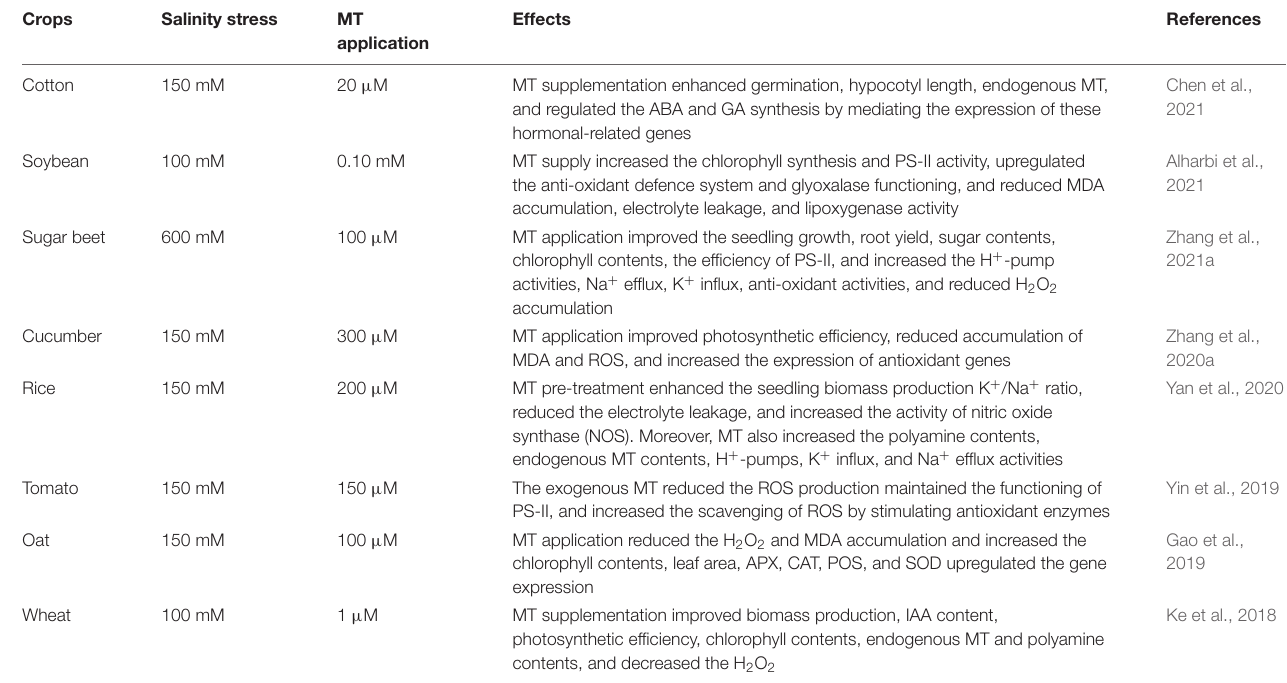
TABLE 1 | Role of melatonin in inducing salt tolerance in different plant